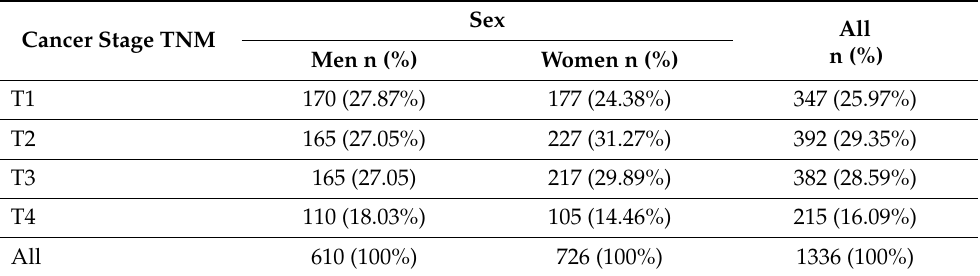
Table 3. Sex distribution in cancer stage according to TNM classification of malignant tumors (at the time of